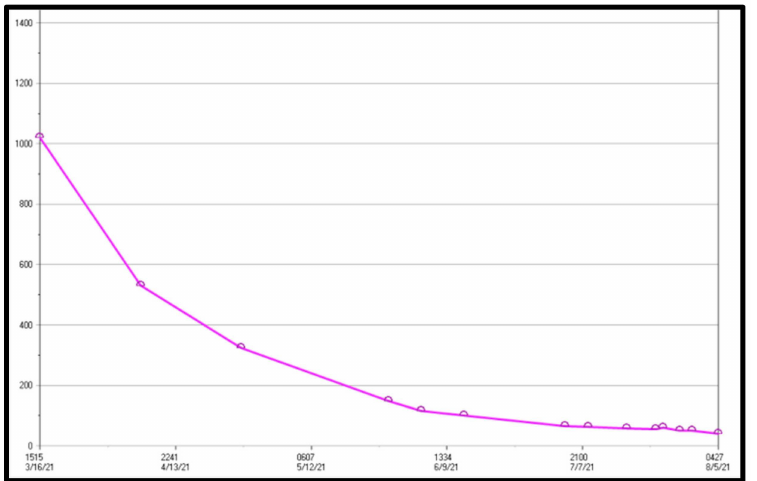
Figure 3. Beta hCG trend from one month post initiation of chemo to day 60 of ECMO